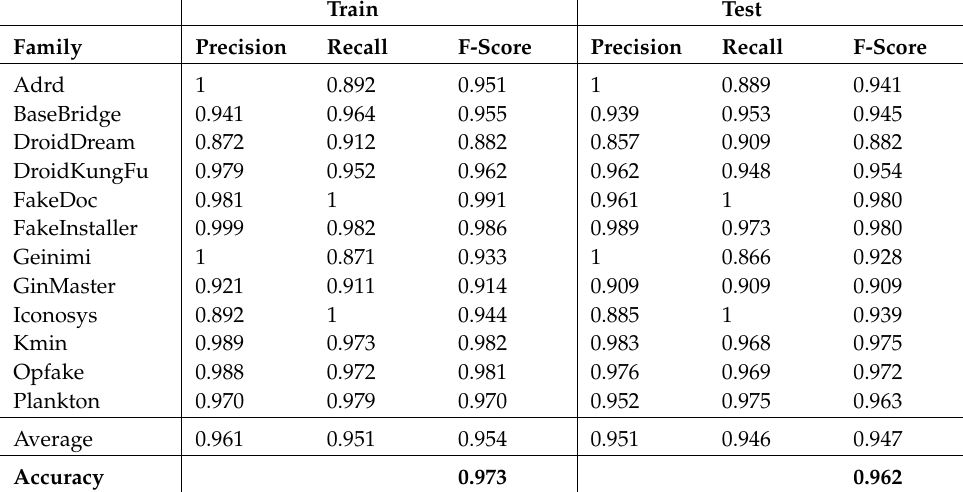
Table 3. Confusion matrix summarization.